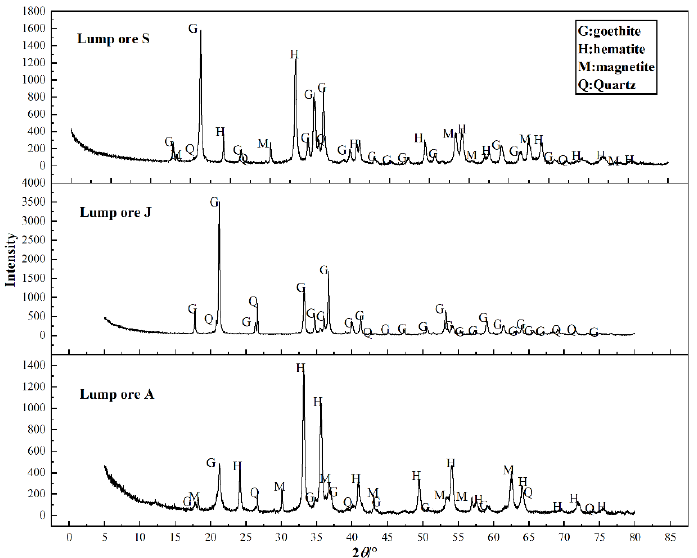
Figure 1. XRD analysis results of the three lump ores.